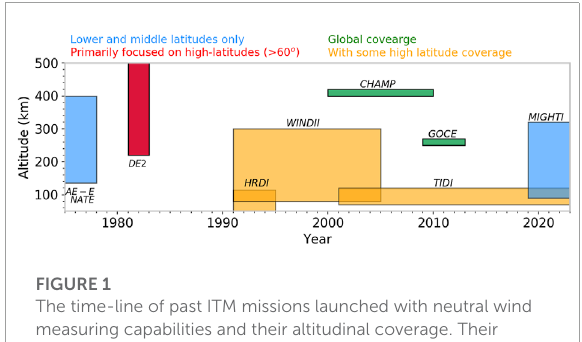
FIGURE 1 The time-line of past ITM missions launched with neutral wind measuring capabilities and their altitudinal coverage. Their latitudinal coverages are indicated with colors on the top.